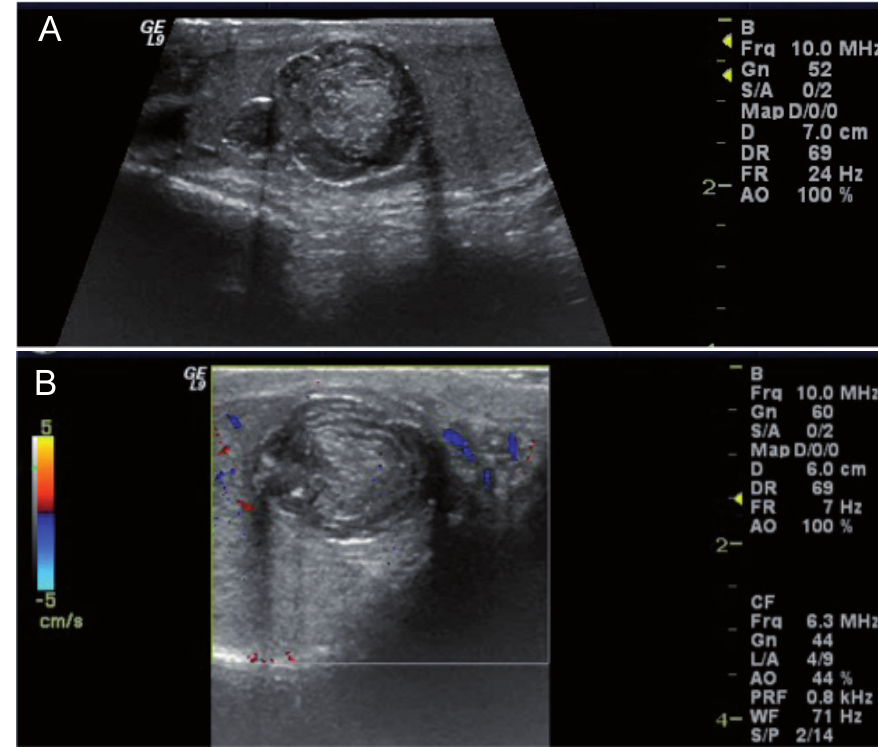
Figure 1 - a. Longitudinal US image of the right testis show a bilobulated mass in the upper medial aspect of the testis. The mass had sharp margins, composed of a central echogenic area and of alternating hyperechogenic and hypoechogenic rings in the periphery (onionskin sign), measuring 2.4 x 1.7 x 1.7 cm. b. Longitudinal Doppler-US image of the right testis demonstrates the absence of vascularization of the